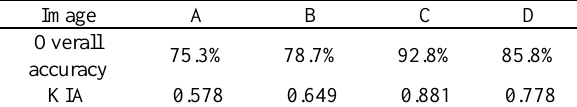
Table 5. Classification accuracy